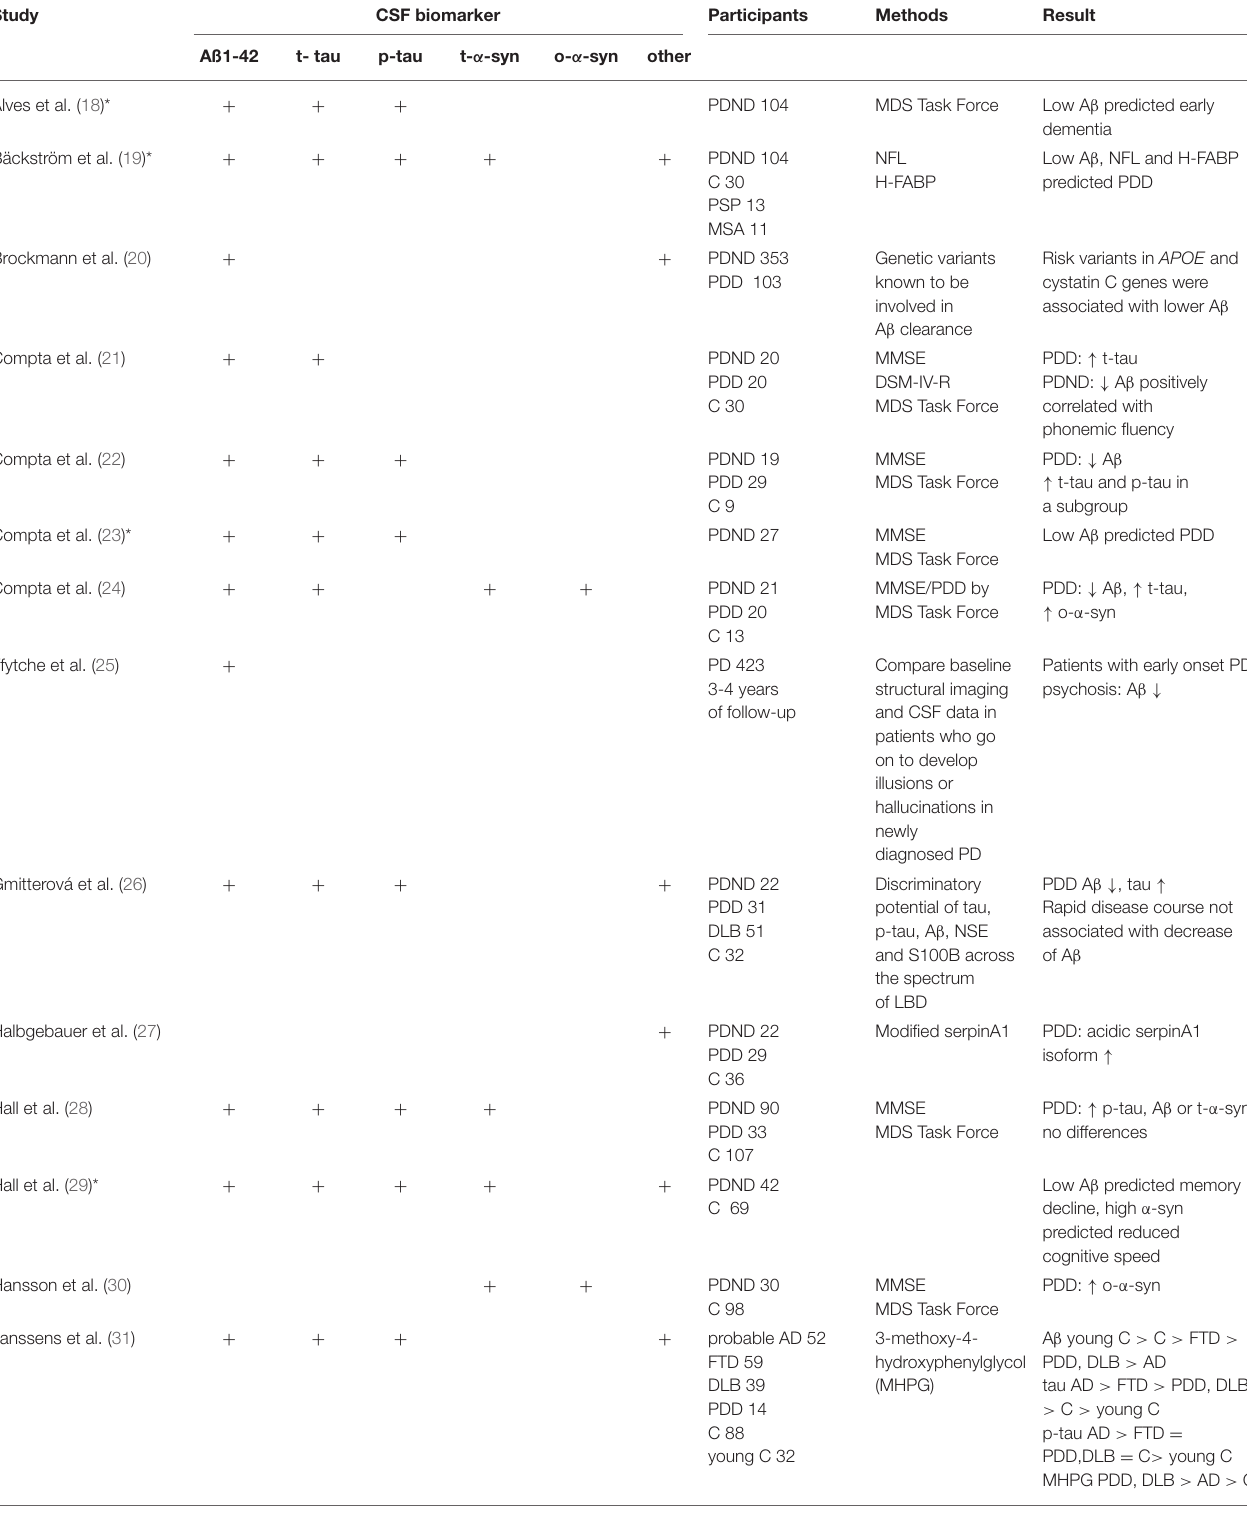
TABLE 1 | Cerebrospinal-fluid (CSF) biomarkers of cognitive impairment and dementia in Parkinson’s disease.